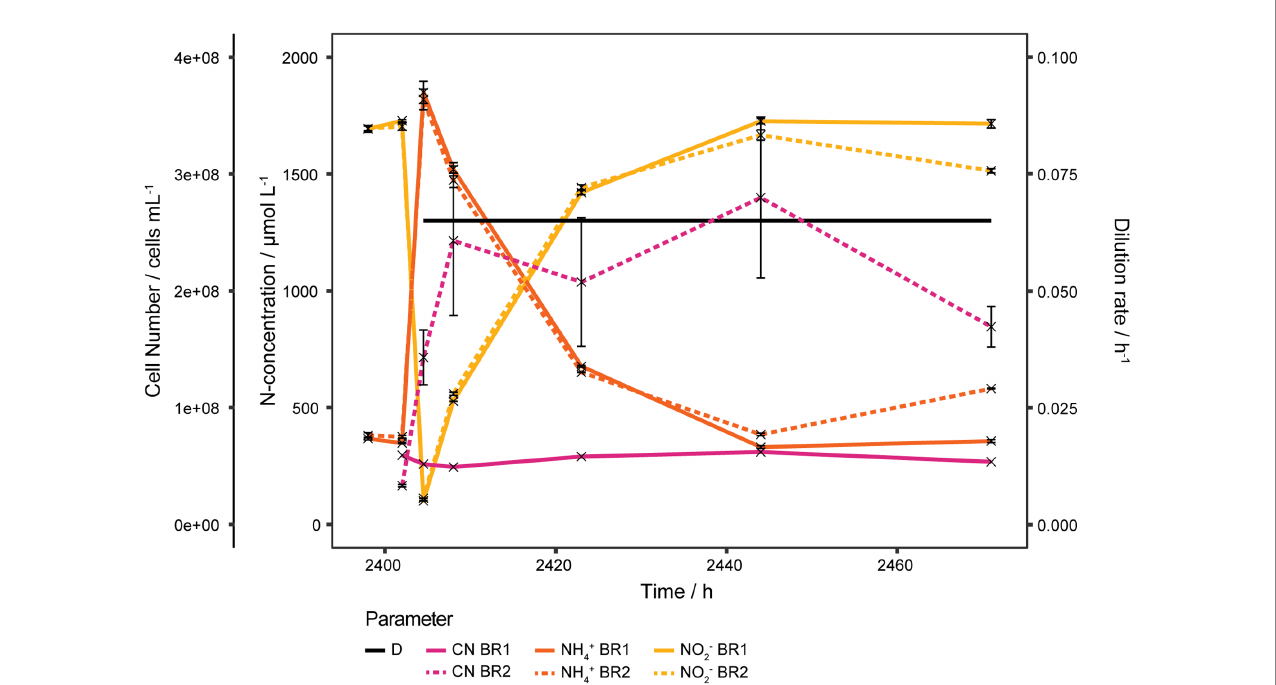
FIGURE 3 Ammonia oxidizing activity of biofilm. Bioreactors of continuous cultures grown at high D were washed, refilled with sterile medium and operated at D 0.065 h − 1 to estimate the activity of the biofilm which had formed on the reactor walls due to the prolonged cultivation time. NH 3 oxidation started right away and within 2 days the same steady state as before the washing step was recovered in both reactors. Cell number in BR1 was almost unaffected by the washing step, indicating that most planktonic cells were seeded by the biofilm. The steep increase of the cell number in BR2 was due to biomass being scraped off from the reactor wall by precipitate that had formed at the inlet and was washed off during the washing step. Both reactors exhibited very comparable NH 3 oxidizing activities despite the fact that BR2 lost a considerable amount of its biofilm biomass as it was washed out with the effluent. NH 4+ , NO 2 − , and cell number of BR2 curves show mean values of technical triplicates and error bars represent the standard deviation of the mean. Points with small standard deviation may not have visible error